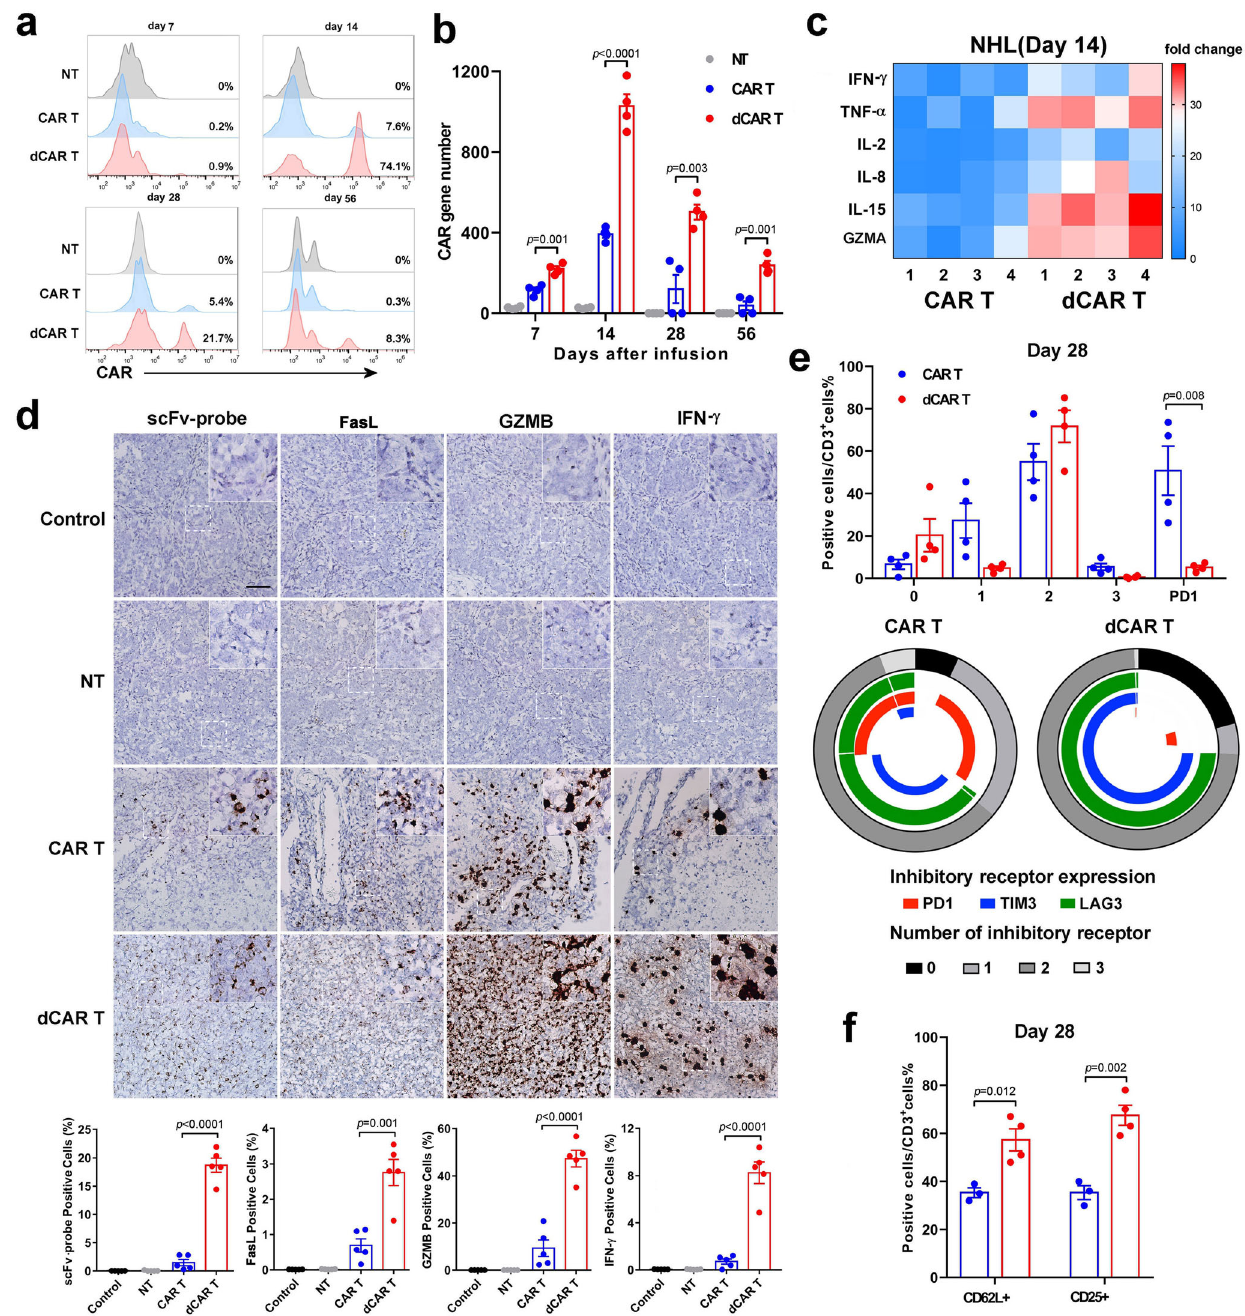
Fig. 8 Enhanced in vivo antitumour function and reduced exhaustion of dCAR T cells. a Representative histograms showing the percentage of CAR T cells in the PB at the indicated time points are presented and were used to evaluate the in vivo expansion of CAR T cells. b The CAR gene number from PB samples taken from mice-bearing tumours from Raji cells treated with 1 × 10 6 CAR T cells in each group collected at serial time points after cell infusion was measured by Q-PCR using primers speci fi c for the transgene ( n = 4 mice over two independent experiments). c Cytokines from the sera of venous blood samples from mice from ALL model experiments ( n = 4 mice over two independent experiments) collected at 14 days after cell infusion were measured by FACS. All data are the fold change in the value measured in the test group compared to that in the control group. Colours indicate fold changes of cytokine levels. d Upper panel: Mice-bearing tumours from Raji cells treated with 1 × 10 6 CAR T cells were sacri fi ced on day 14 after treatment. Paraf fi n tumour sections were stained with CAR scFv-, granzyme B- (GZMB-), IFN- γ - and FasL-speci fi c probes for RNA ISH. Scale bar: 100 μ m. Lower panel: The positive cell count value is the mean value from ten randomly selected fi elds in each slice ( fi ve slices from three mice in two independent experiments). e Upper panel: Statistical analysis of differences in the ratio of cells expressing the non, 1, 2 or 3 phenotypes (PD1, LAG3 and TIM3) of the CAR T cells. Lower panel: Expression of PD1, LAG3 and TIM3 in CAR T cells. f Expression of CD3/CD62L and CD3/CD25 on CAR T cells. To obtain the data in ( e ) and ( f ), cells were collected from the bone marrow of Raji tumour cell-bearing mice treated with 1 × 10 6 CAR T cells on day 28 after cell infusion ( n = 4 over two independent experiments). Data for b , d , e and f are presented as the mean ± s.e.m. P values for b , d , e and f were calculated by two-tailed unpaired t